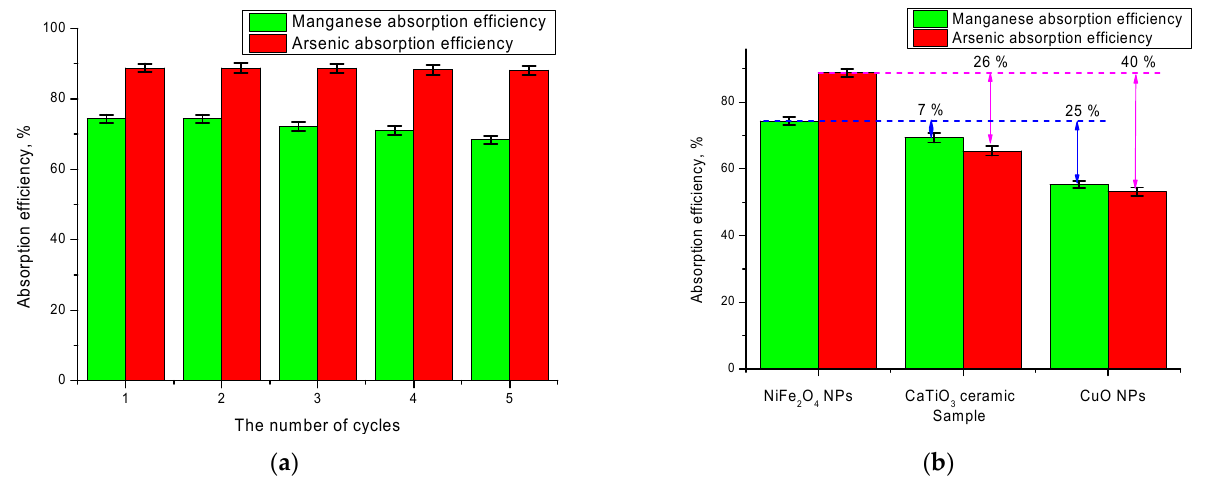
Figure 7. ( a ) Absorption efficiency diagram during five cycles; ( b ) comparative absorption efficiency diagram of synthesized nanoparticles with commercial analogs.